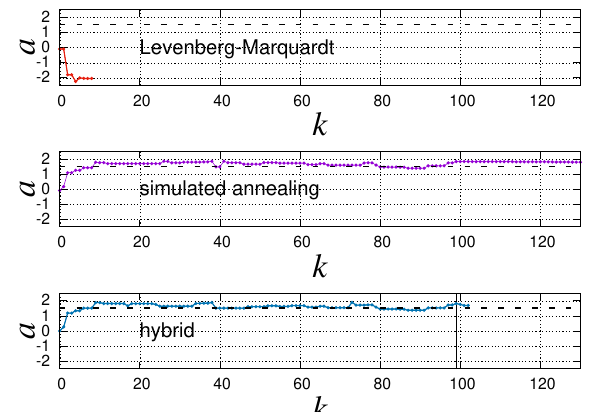
Figure 8. Reconstructed ¯ a ( = 1.5) by (top) Algorithm 1 (LM), (middle) Algorithm 2 (SA), and (bottom) Algorithm 3 (hybrid) for the initial value a 0 = −